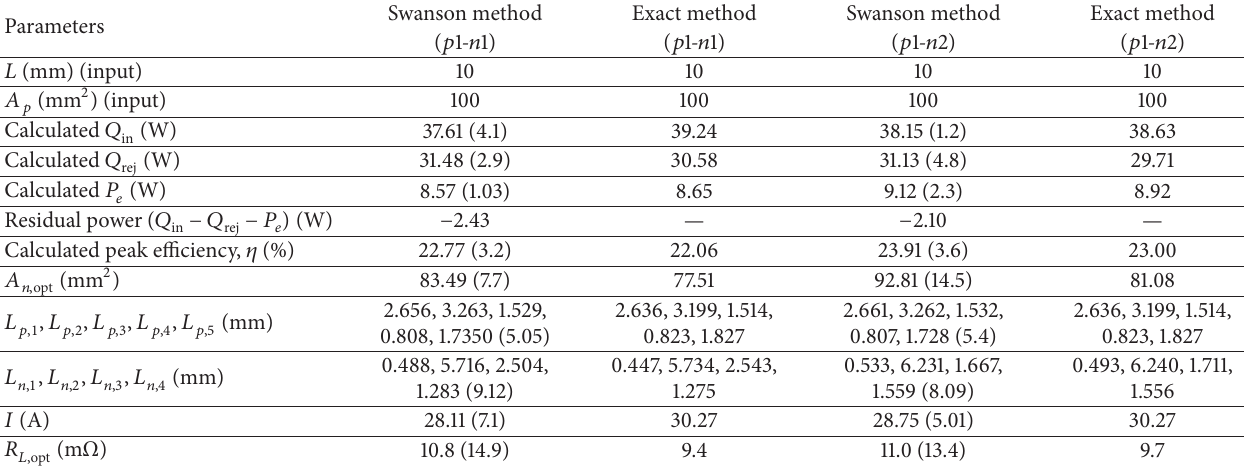
Table 2: Design and performance characteristics of 𝑝 1- 𝑛 1 and 𝑝 1- 𝑛 2 generators at maximum efficiency, calculated through both exact and Swanson et al.’s [13] methods. The differences between Swanson et al.’s and exact results are shown in parenthesis. 𝐴 𝑝 and 𝐿 are assumed as constant inputs of the optimization